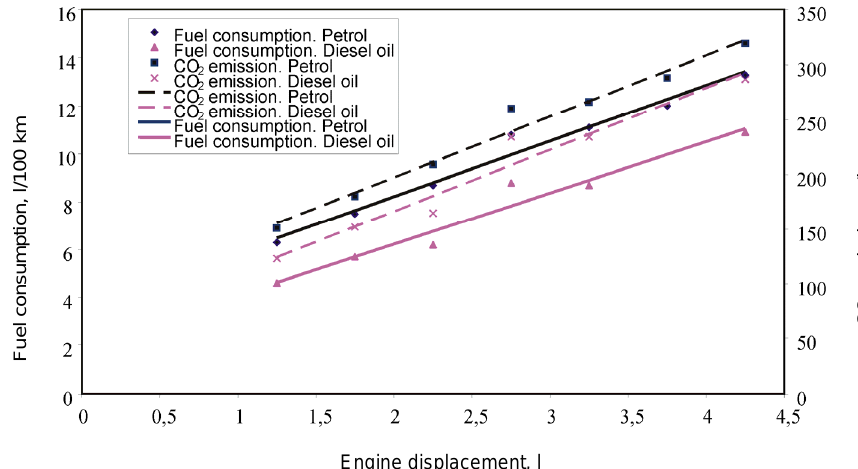
Fig 4. The relationship between fuel consumption and CO 2 emission of an automobile and its engine displacement